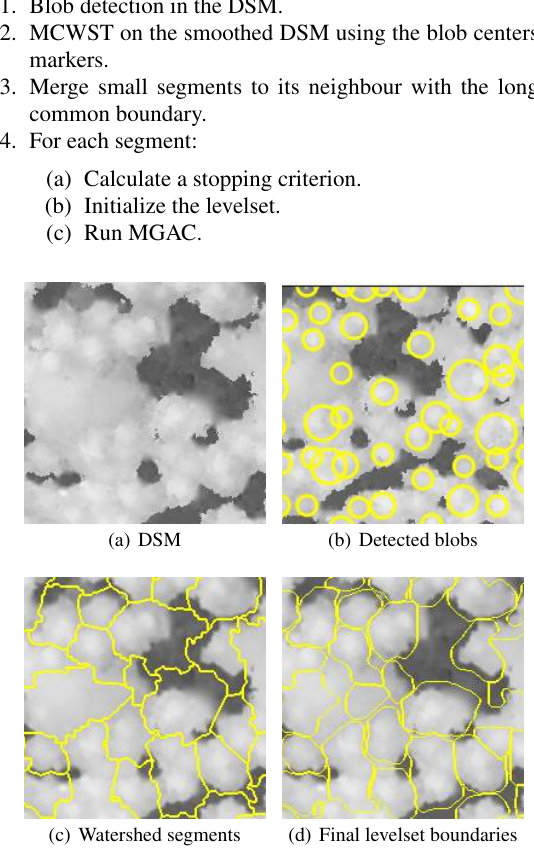
Figure 3. Illustration of the main processing steps of